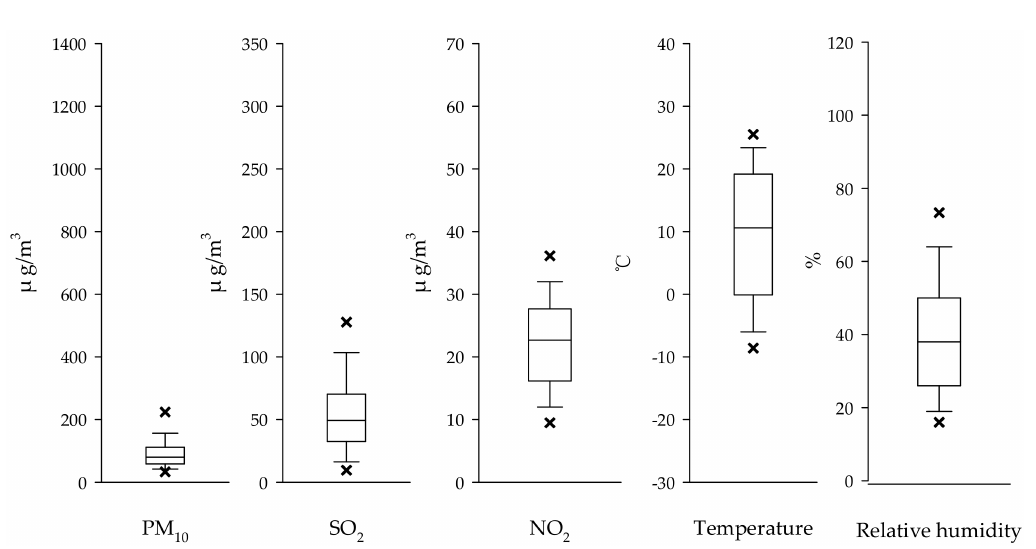
Figure 1. Box plot of PM 10 , SO 2 , NO 2 , Temperature and Relative humidity in Jinchang city, Gansu Province, China, 2011–2015. ( × represent the 5th/95th percentiles of each value).